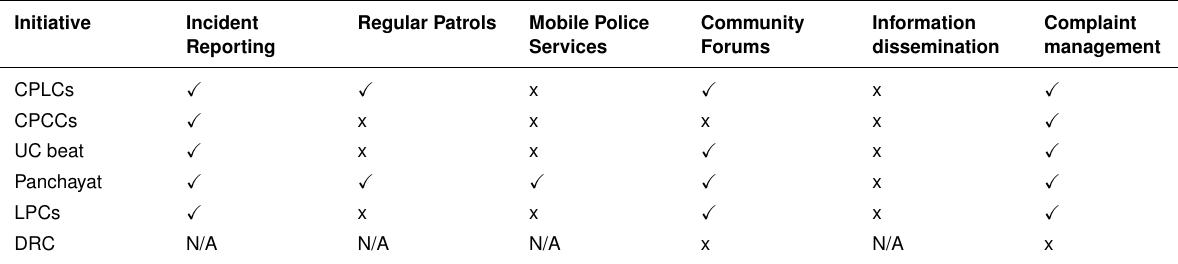
Table 2. Analysis of COP initiatives in